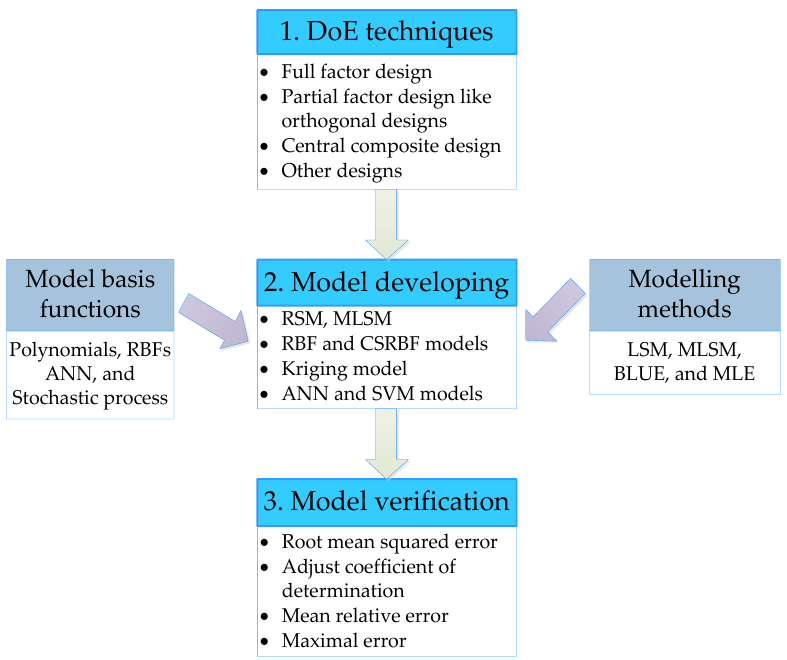
Figure 5. Design flowchart for surrogate models.